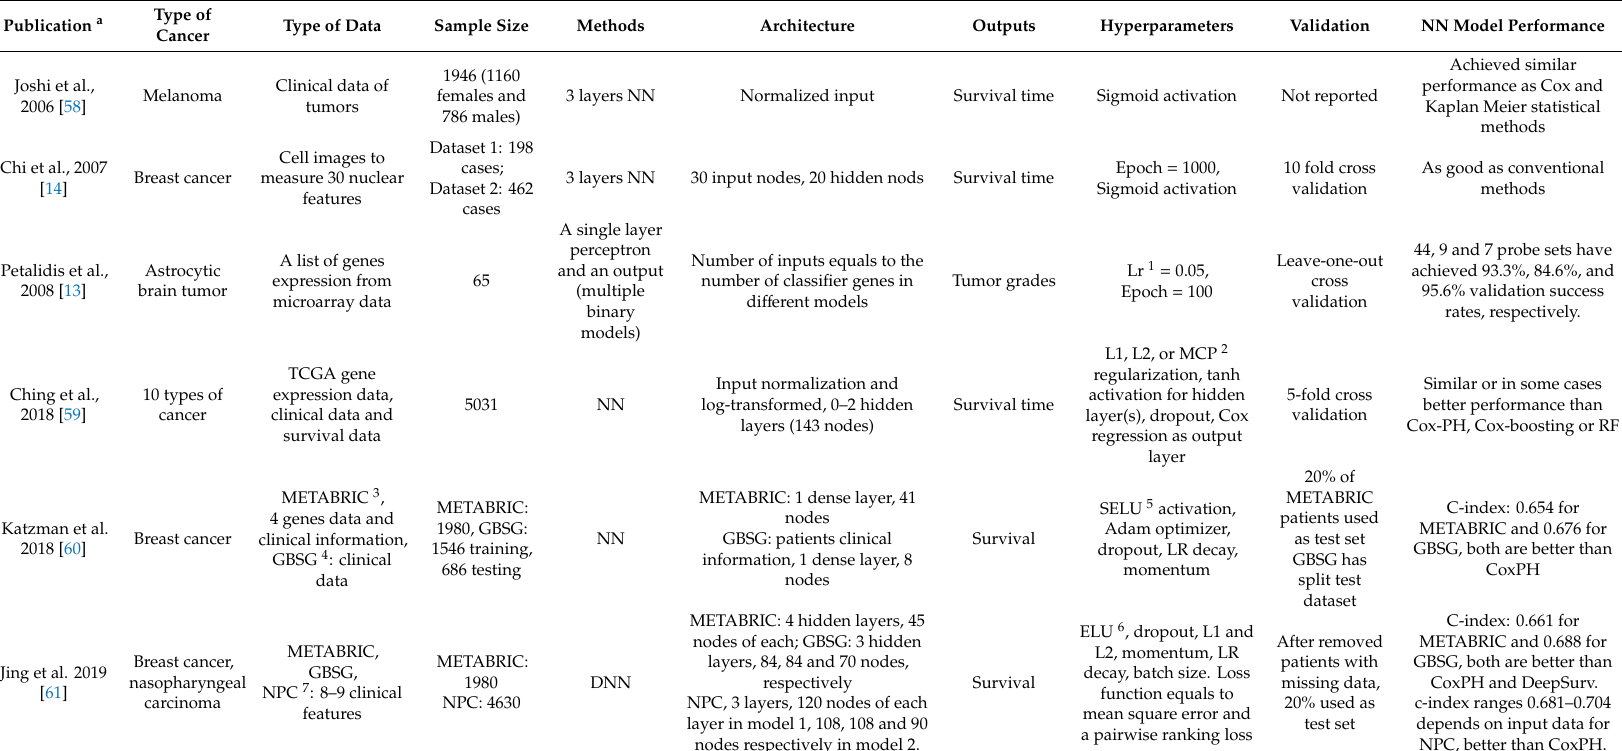
Table 1. Summary of neural network models with no feature